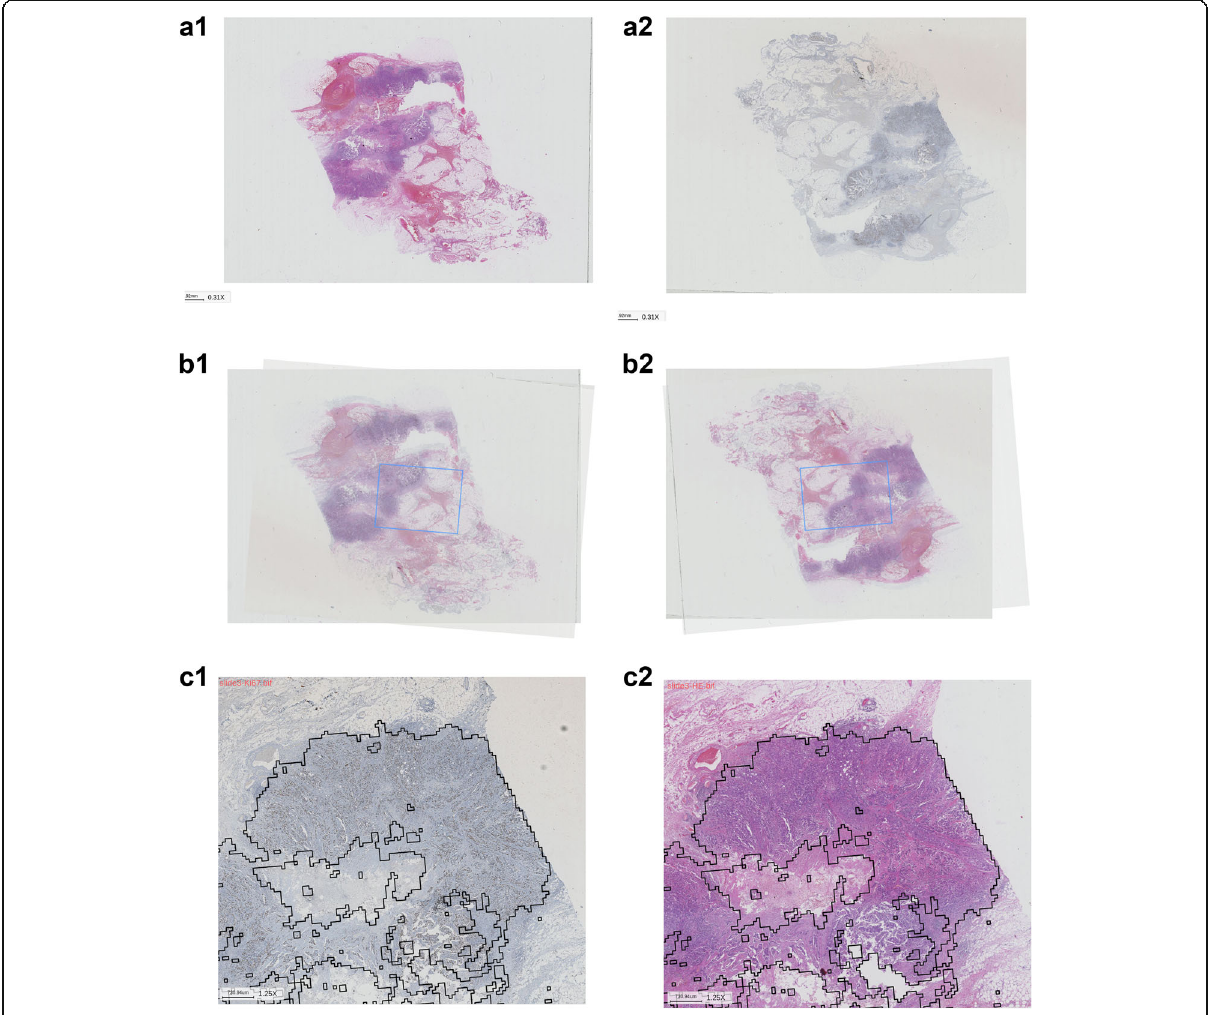
Fig. 4 Ki-67 staining and corresponding registration results of IDC regions. The figure illustrates contiguous HE slides and Ki-67 stained slides that were perfectly registered (in most cases). a , Contiguous HE slides and Ki-67 stained slides. b , Registering. c , Registration results of IDC region in the Ki-67